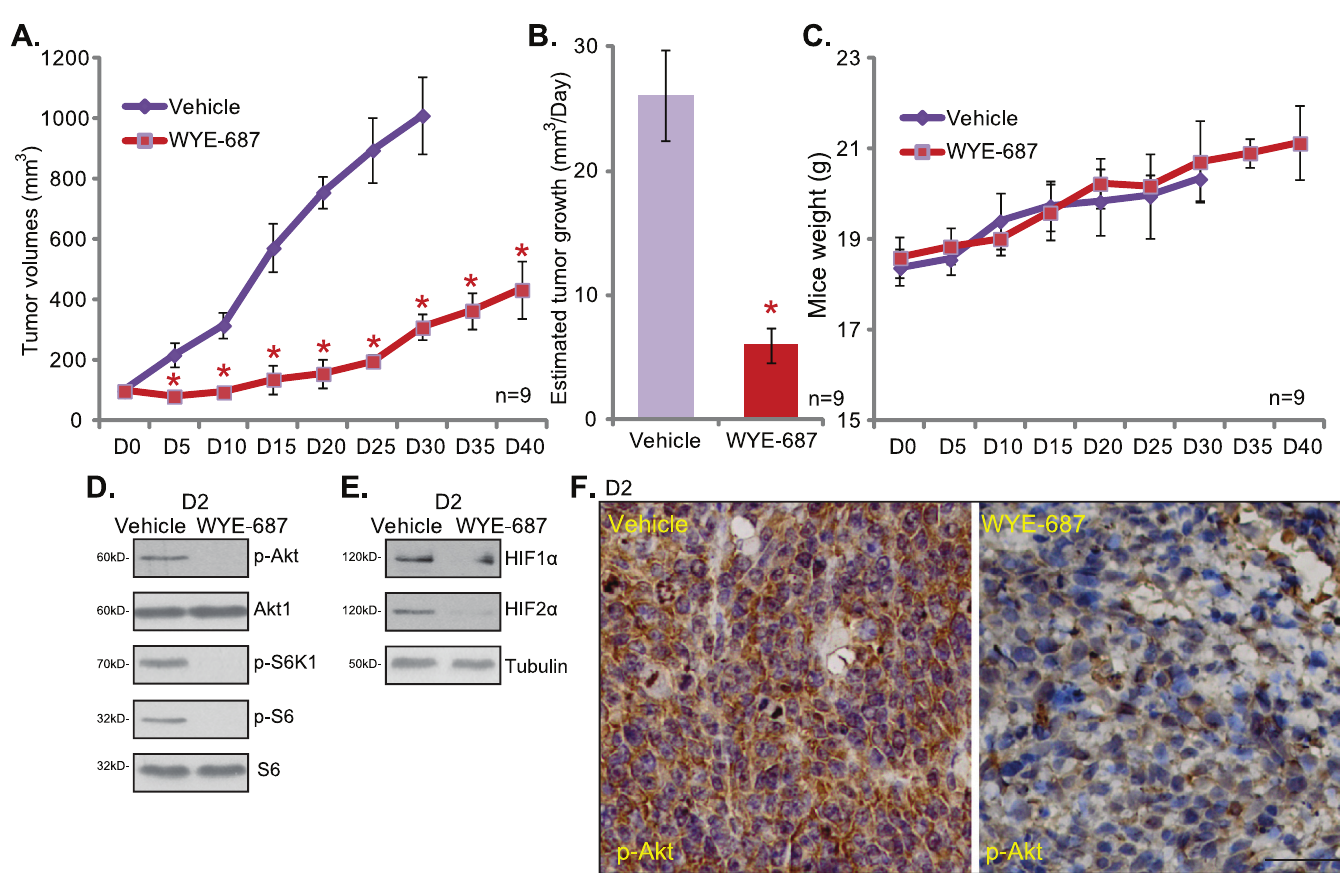
Fig 5. WYE-687 oral administration inhibits 786-O RCC tumor growth in nude mice. The growth curve of 786-O xenografts in nude beige mice with daily administration ofWYE-687 (oral gavage, 25 mg/kg body weight)or vehiclecontrol (“Vehicle”) was presented (A). Each treatment group comprised9 mice, mean estimated tumor volume (A) and mice body weight (C) were recordedevery 5 days. Estimated daily tumor growth was also presented(B). To test signaling changes,at treatment day-2, one mice per group was sacrificed, and tumor xenografts were excised; Expressions of indicatedproteins in xenograft tissues were analyzedby Western blot assay (D and E) and IHC stainingassay (F, bar = 50 μ m). * p <